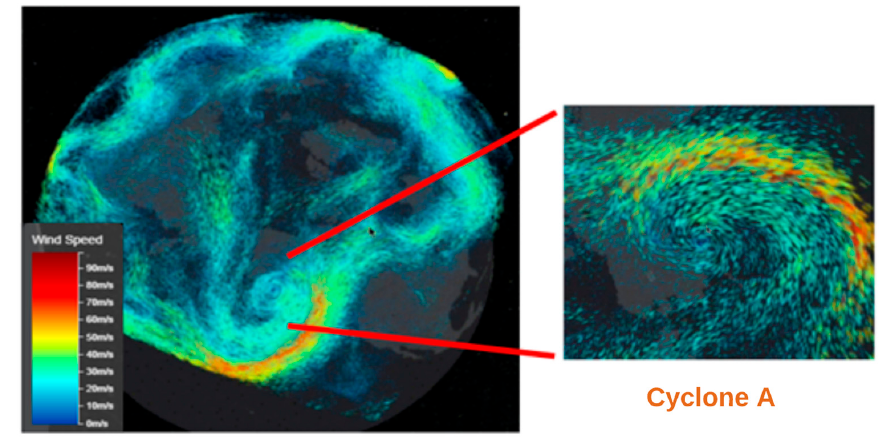
Figure 8. Screenshot of the wind field visualization (262,144 particles). Table 1. Performance test (particle render time consumption, particle advection time consumption, frame rate) with different particle